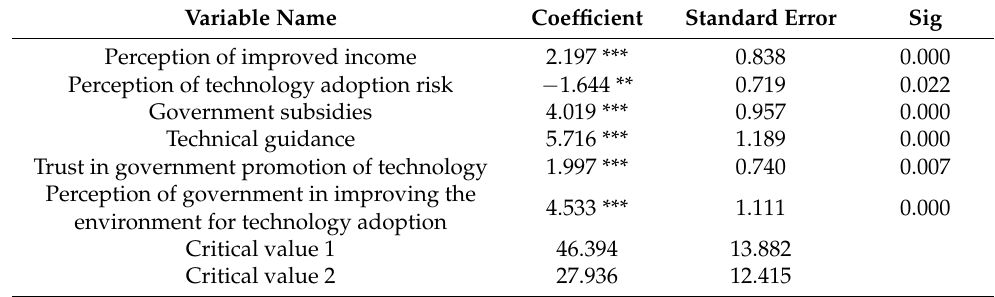
Table 7. Estimation result of farmers’ willingness to adopt biopesticide application technology.